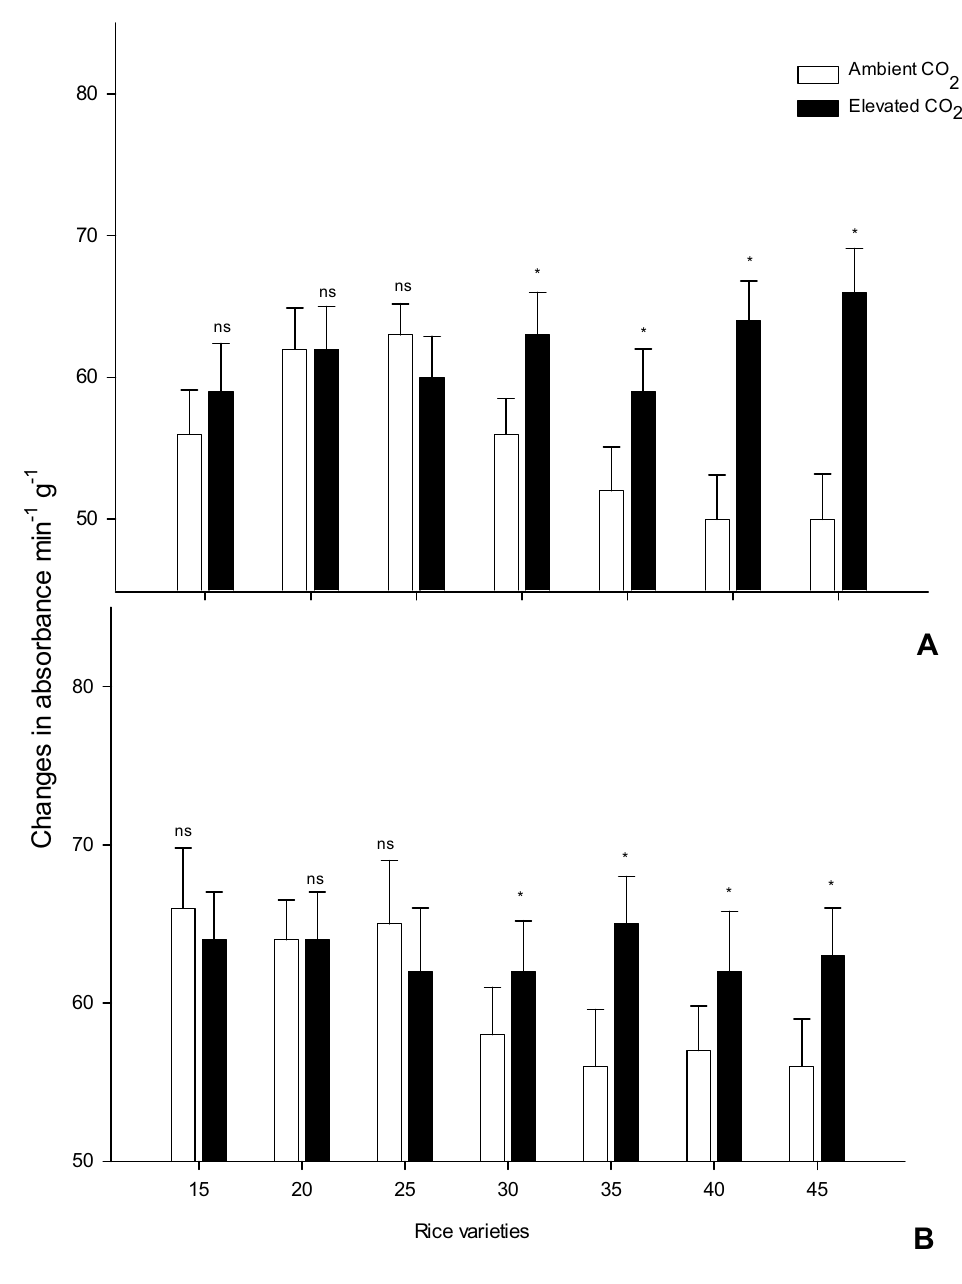
Figure 4. The peroxidase enzyme (PO) content in rice leaves grown in ambient and e CO 2 (Values are means ± SEM of five replications) (Mean (± SEM) followed by the symbol * in an individual experiment indicate significant difference (P < 0.05) in a Tukeys test) (ns-non